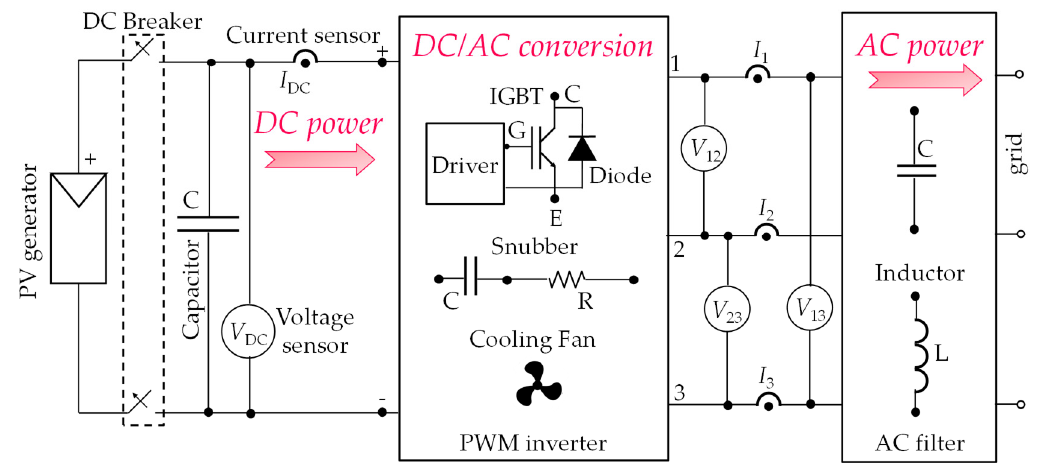
Figure 3. Main components and corresponding power fluxes of Direct Current/Alternating Current (DC/AC) converters.